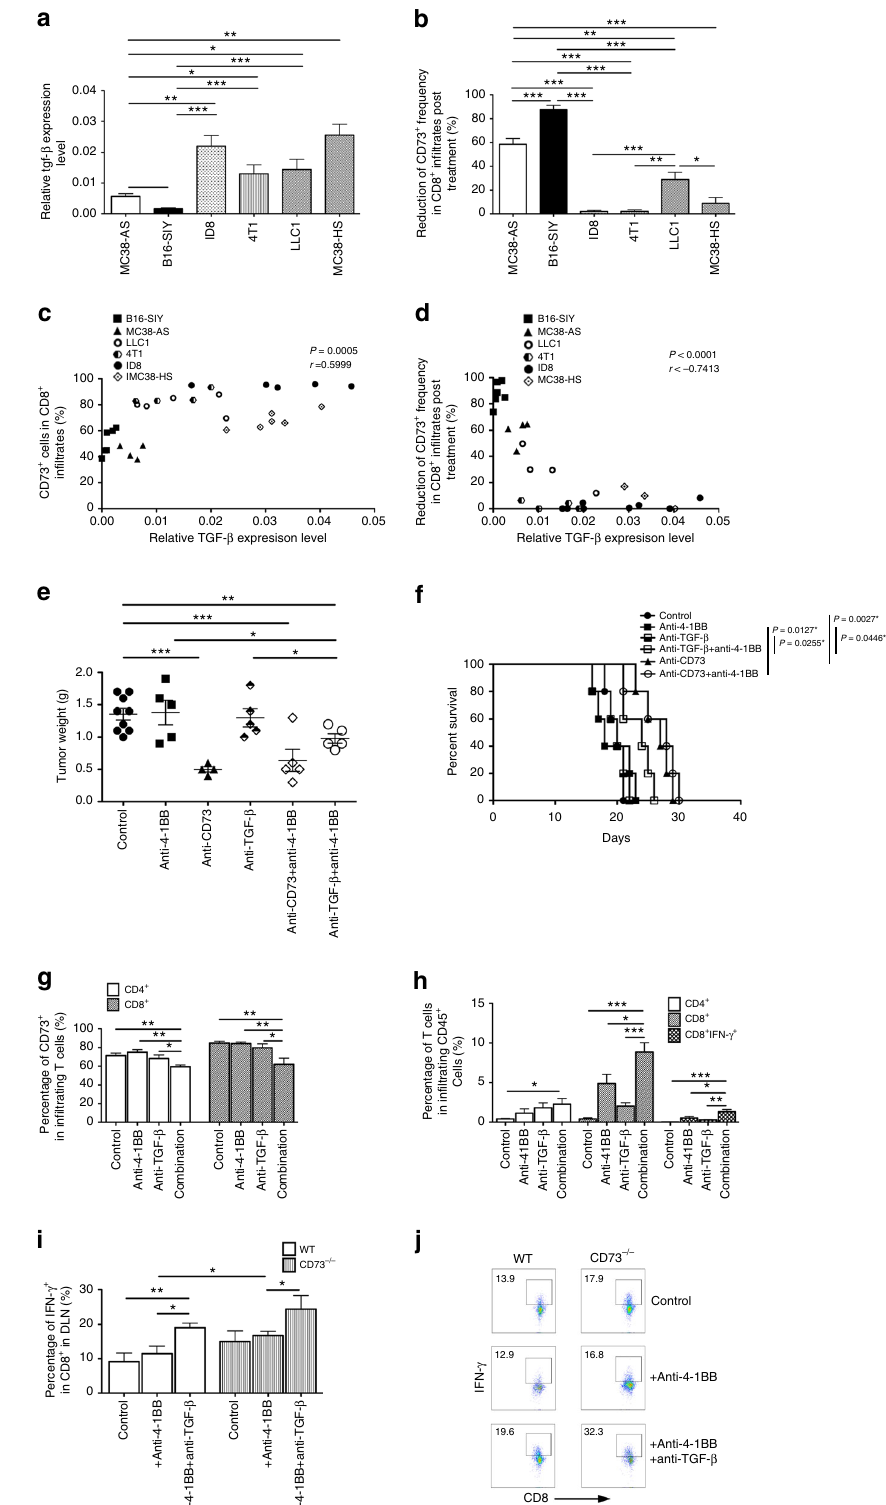
neutralizing anti-TGF- β mAb restored the 4-1BB-elicited potent antitumor activity as comparable to anti-CD73 monotherapy (Fig. 5e, f), whereas neither anti-TGF- β or anti-4-1BB alone was able to inhibit tumor growth (Fig. 5e, f). Consistent with these, combination of anti-TGF- β /anti-4-1BB but not each